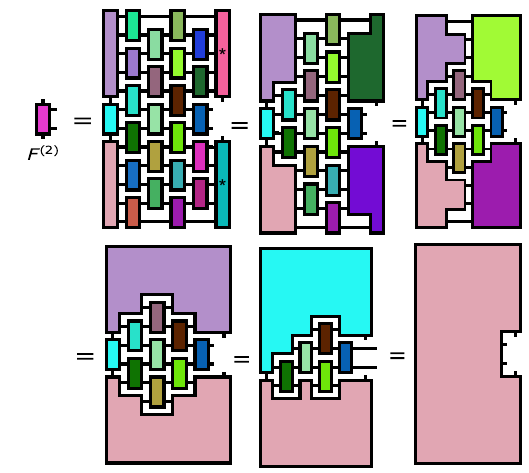
FIG. 5. Contraction path to compute the F (τ)